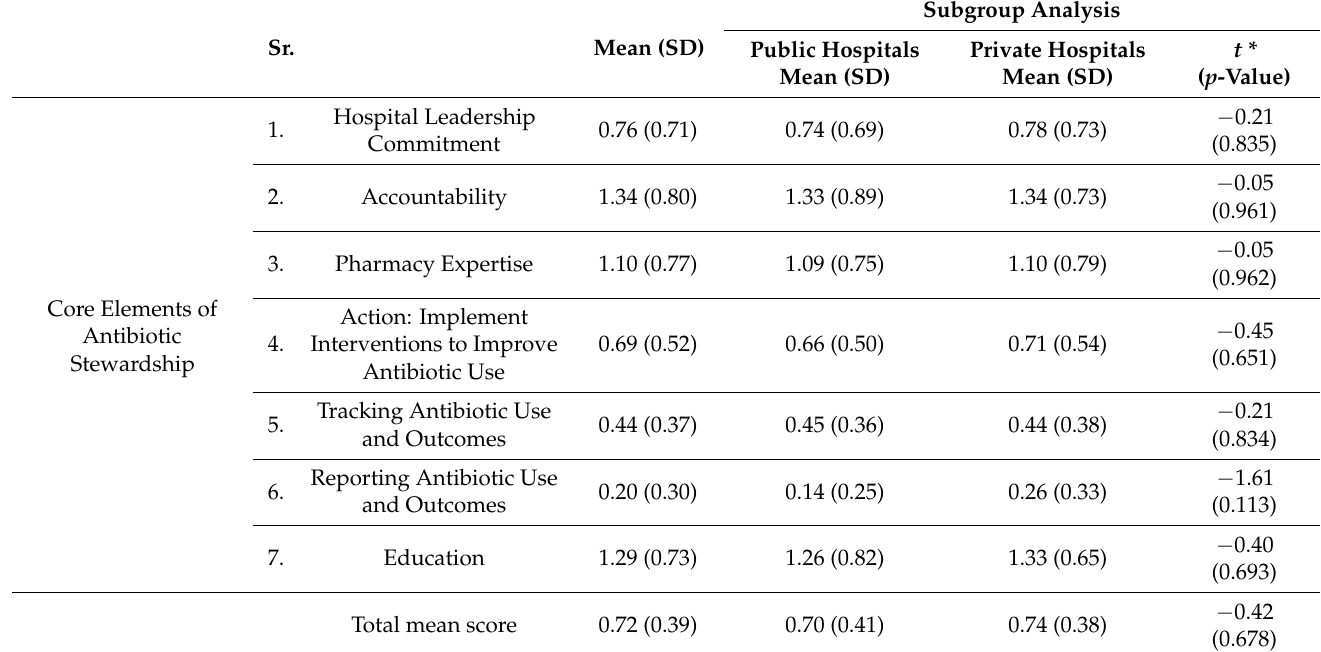
Table 2. Core elements of hospital antibiotics stewardship.